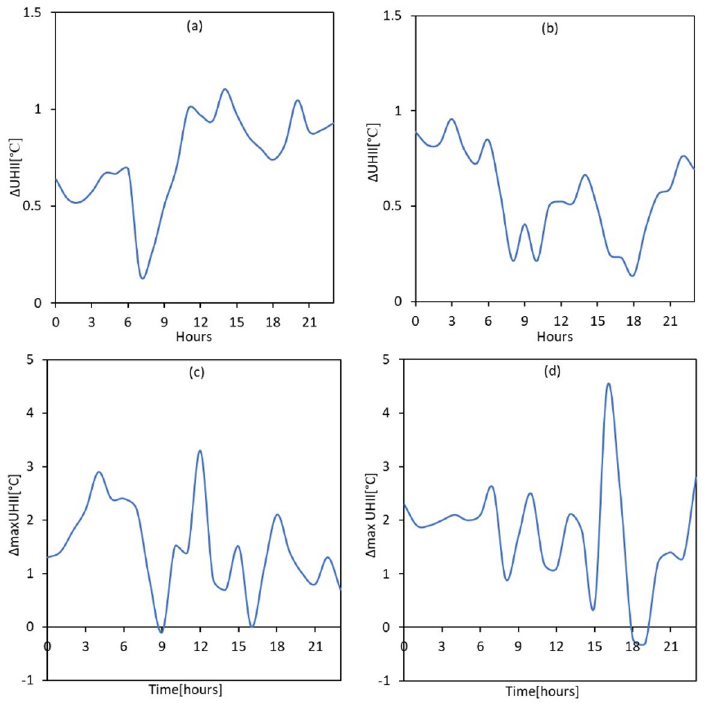
Fig 2. Diurnal differences in UHII magnitude between HW and NHW periods; average maximum UHII values. (a) 2012 (b) 2016; maximum values (c) 2012 (d) 2016.